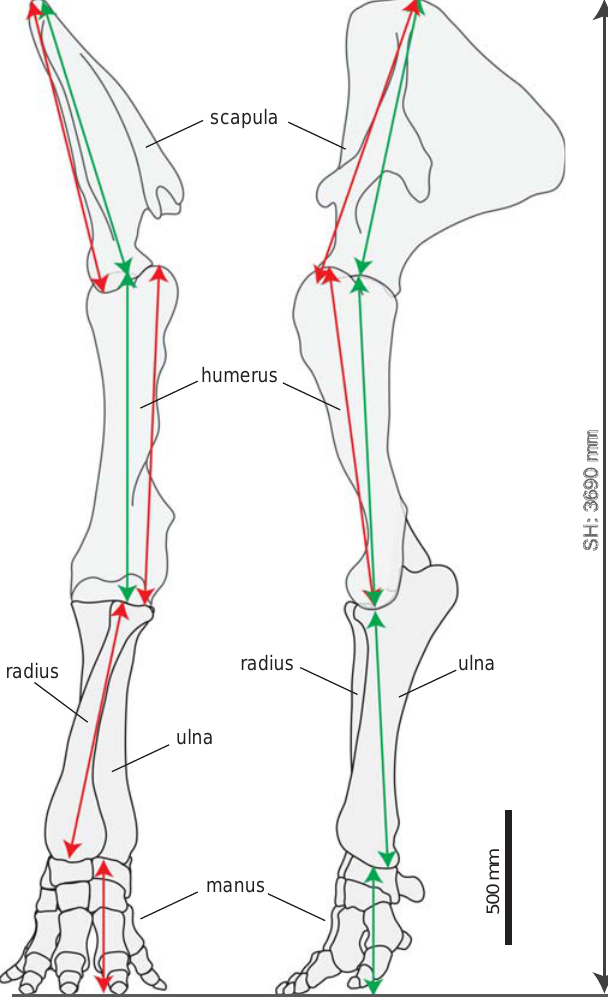
Fig. 1. Reconstruction of the forelimb of the Zhalainuoer III mammoth in anatomical position. The actual shoulder height (black): total height in anatomical position 3690 mm. The height obtained by adding the articular (green): manus (500 mm) + ulna (960 mm) + humerus (1233 mm) + scap- ula (1075 mm) = 3768 mm. Maximal lengths of different bone elements (red): manus (500 mm) + radius (985 mm) + humerus (1274 mm) + scap- ula (1115 mm) = 3874 mm. The actual shoulder height can be calculated by multiplying the result by 0.98 in the case of the sum of articular lengths and by 0.95 in the case of maximal